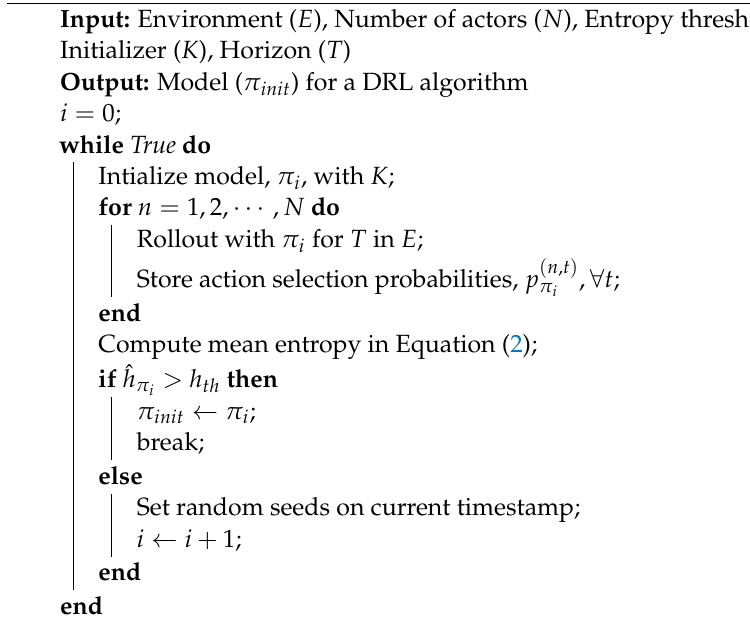
Algorithm 1 Entropy-aware model